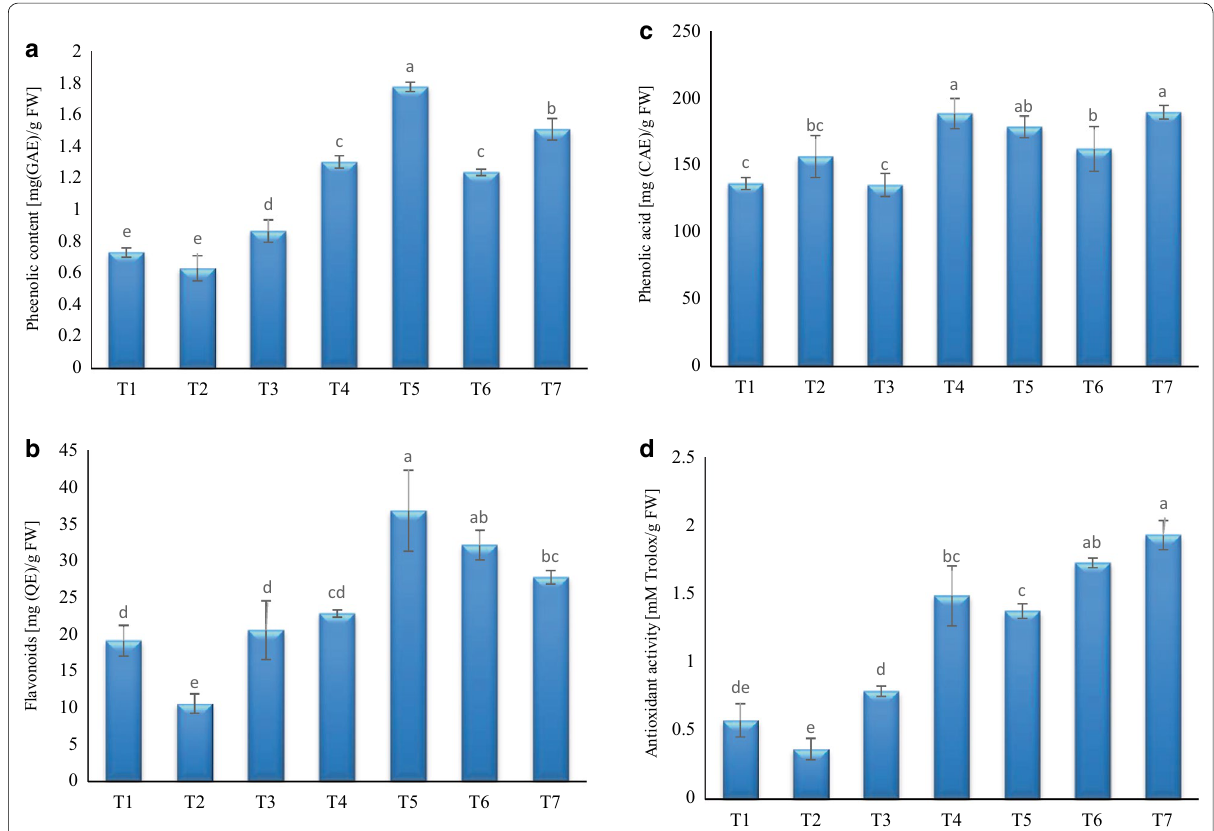
Fig. 2 Influence of selected treatments on a phenolic contents, b flavonoids, c phenolic acids, d antioxidant